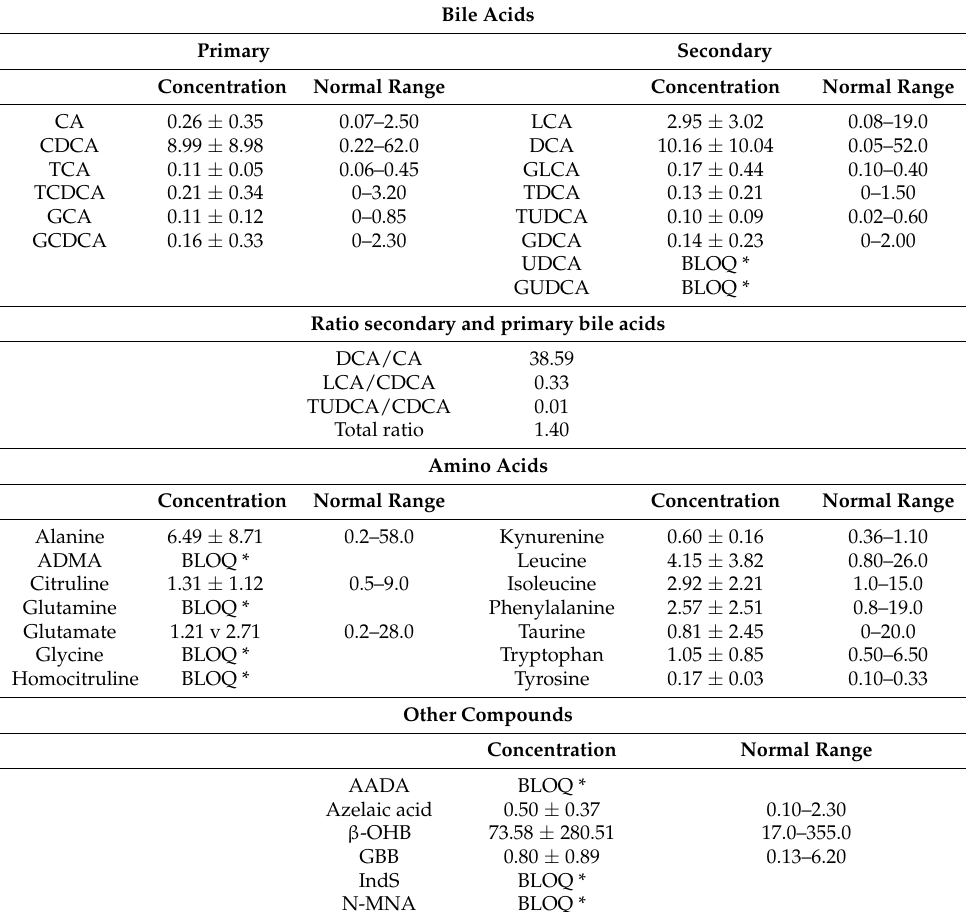
Table 1. Average concentrations (mmol g − 1 of dried sample) and range of concentrations of metabo- lites of relevance for the gut-liver axis in fecal samples from healthy